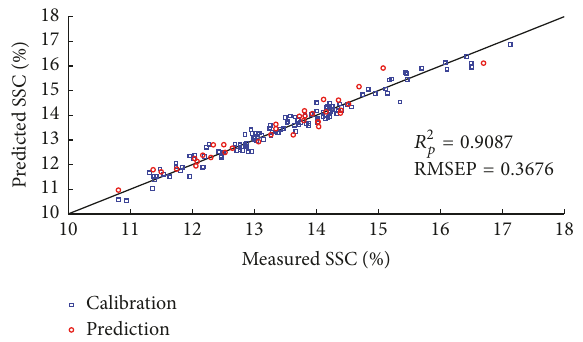
Figure 9: Scatter plots of measured versus predicted values for SSC obtained by the CARS-PLS calibration models.